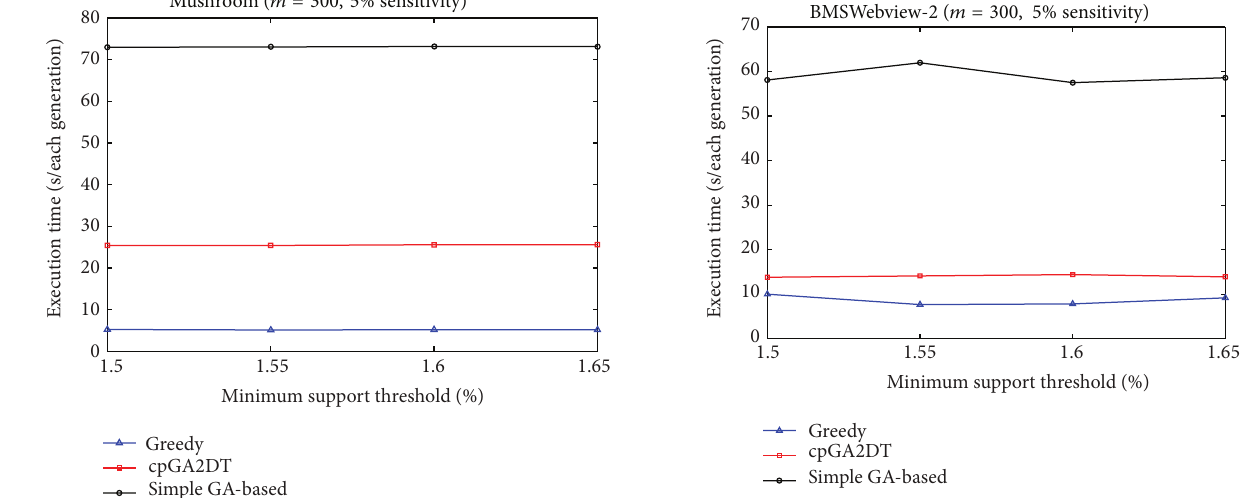
Figure 10: Comparisons of execution time at various minimum support thresholds for mushroom database.